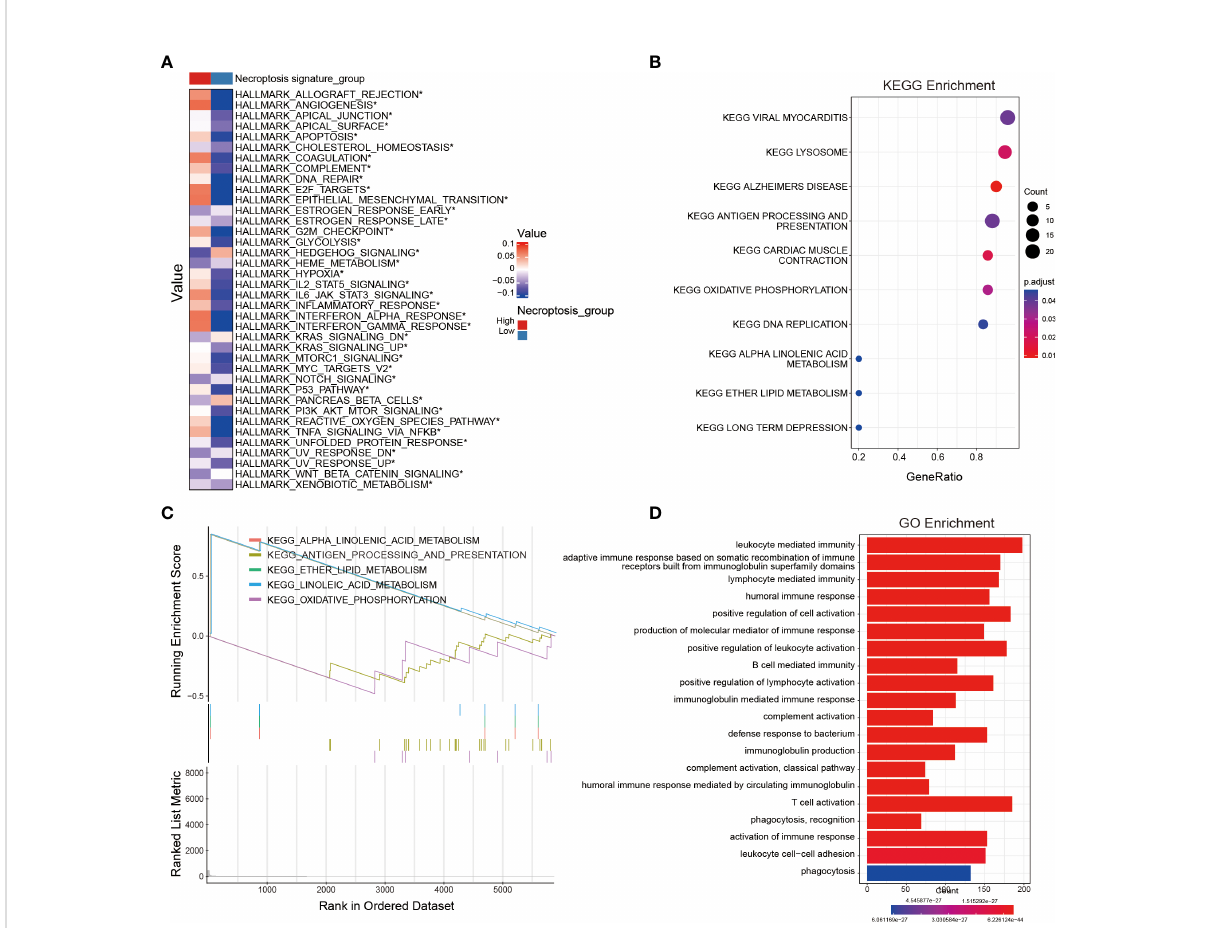
FIGURE 4 Identi fi cation of potential signaling pathways and biological processes associated with the NRS. (A) The hallmark pathway enrichment analysis between NRS groups. (B, C) KEGG and GSEA enrichment analyses revealing the relevant enrichment pathways of DEGs between NRS groups. (D) GO enrichment analysis unveiling the enrichment biological process of DEGs between NRS groups. *: